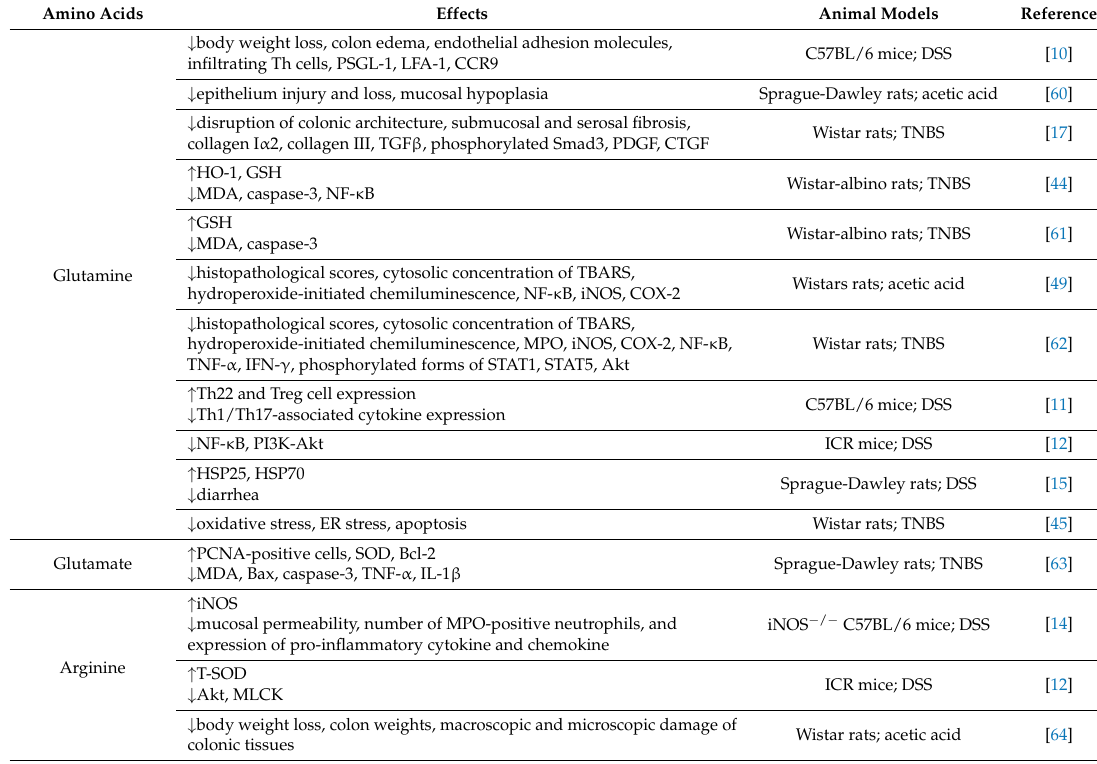
Table 2. Summary of the effect of amino acid supplementation on IBD in animal models. Amino